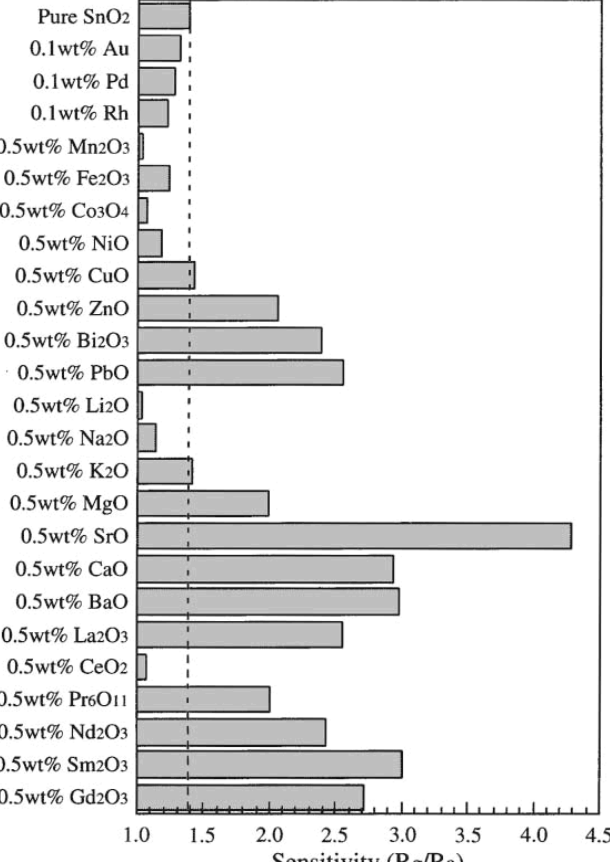
Figure 18. The effect of doping the material with various oxides on the responsivity of SnO to N O gas. Figure adapted with permission from 2 2